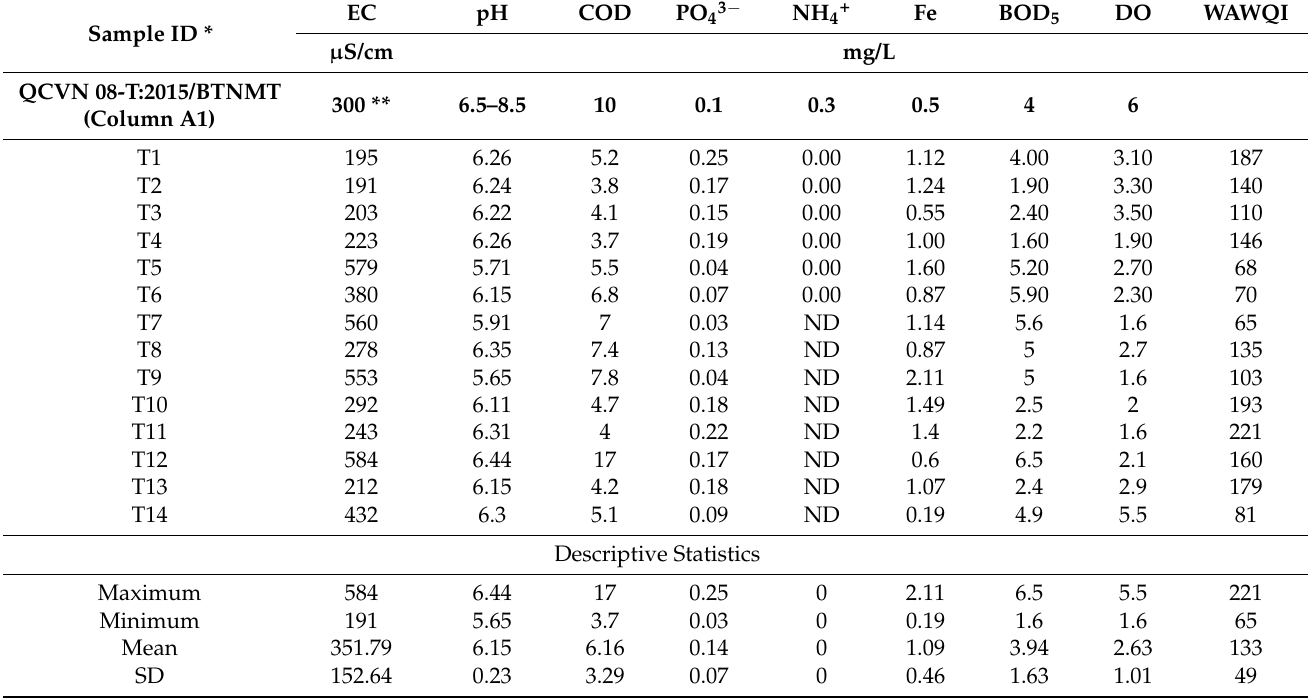
Table 7. Calculation of WAWQI from Data from the MXAC in the 2016 Wet Season.